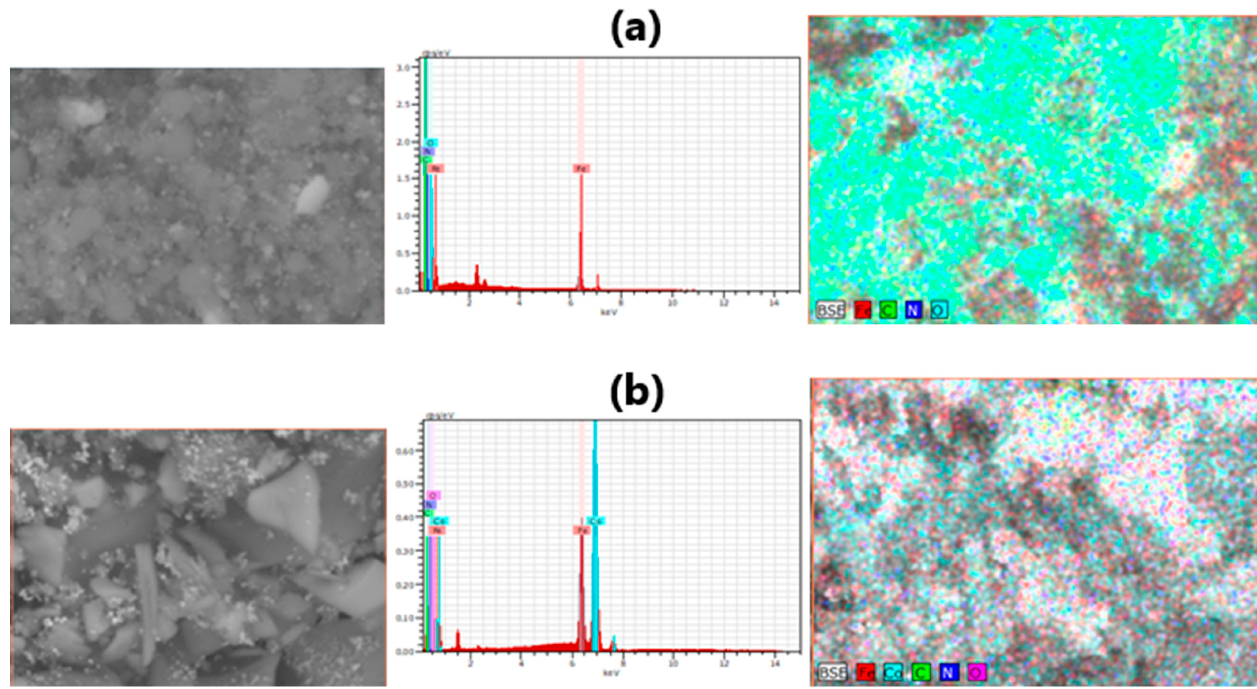
Figure 10. Representative SEM and EDX images of Fe 3 O 4 /P ‐ N ‐ PAA ( a ) and MNP/P ‐ N ‐ PAA ( b ).